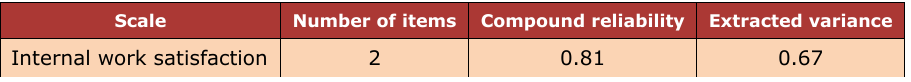
Table 9. Scales reliability